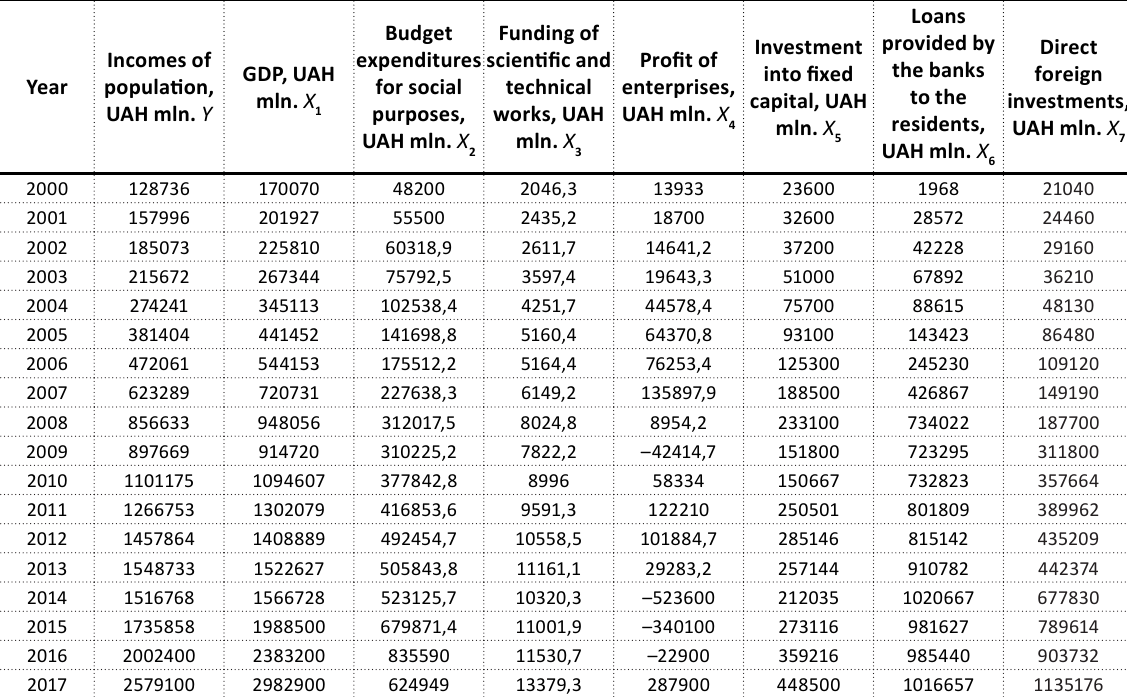
Table 1. Dynamics of source base of providing socialization of economy of Ukraine within 2000–2017